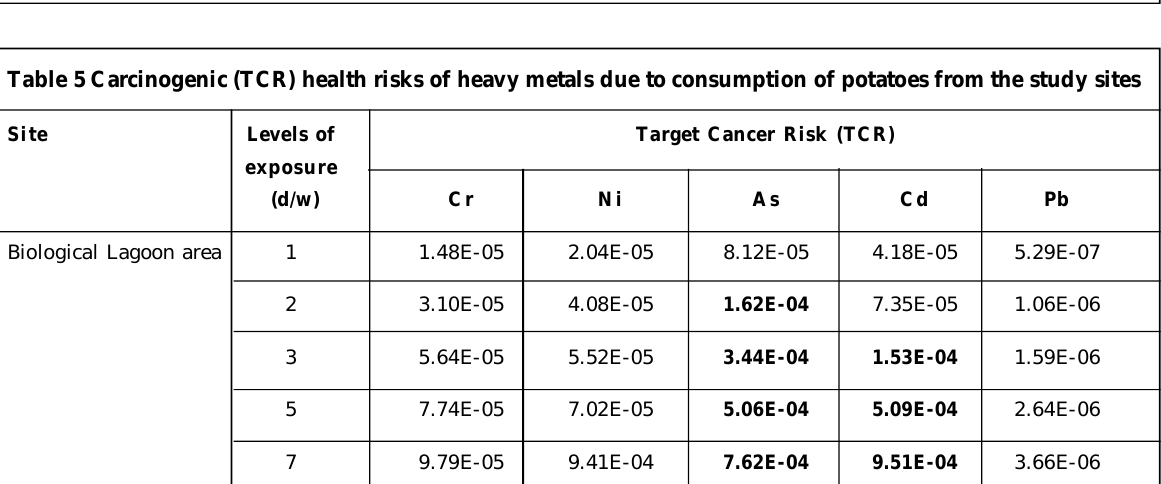
Note: Values in bold indicate TCR above acceptable limit (10 –4 ).